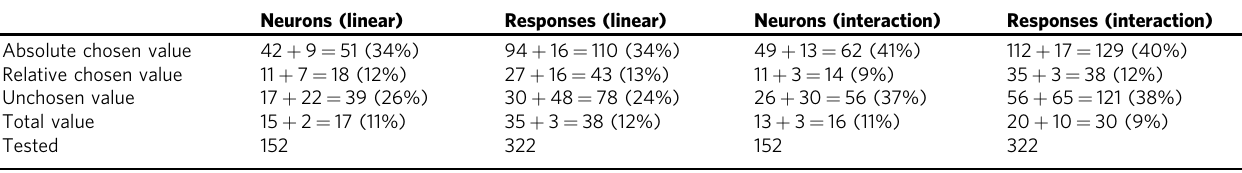
Table 3 Chosen value coding of bundles Neurons (linear) Responses